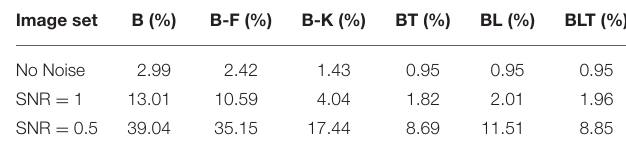
TABLE 4 | Classification error for all of the models on multiple digit recognition with varying numbers of targets.